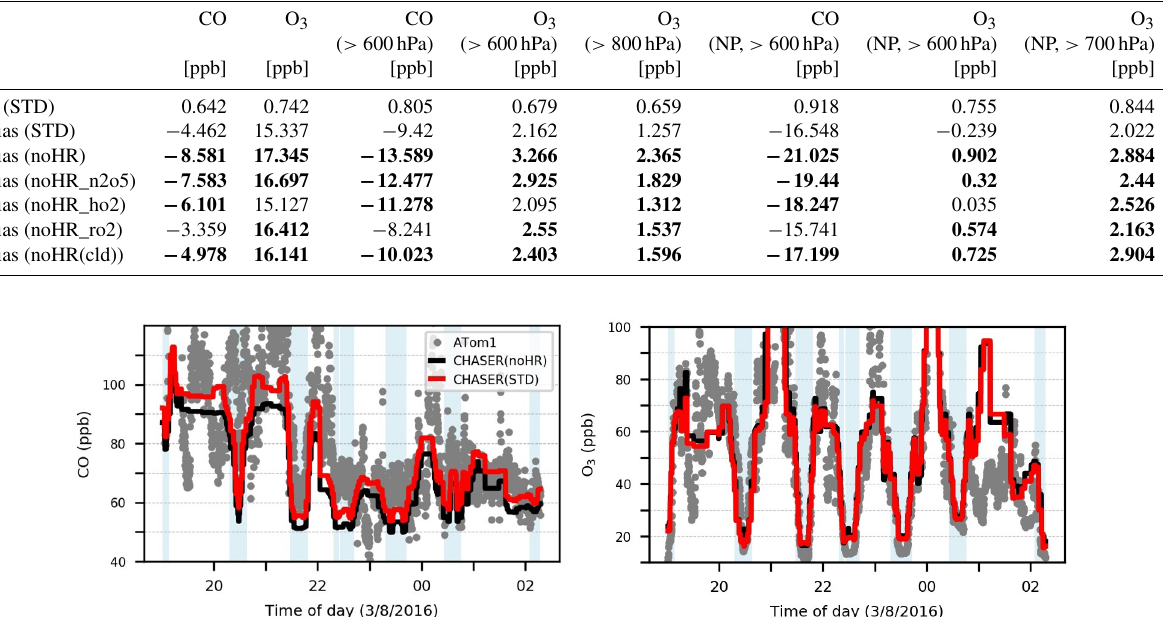
Figure 5. Observations and simulations for CO and O 3 during ATom1 flight 2 (198–210 ◦ E, 20–62 ◦ N). Blue shaded areas show data for P >